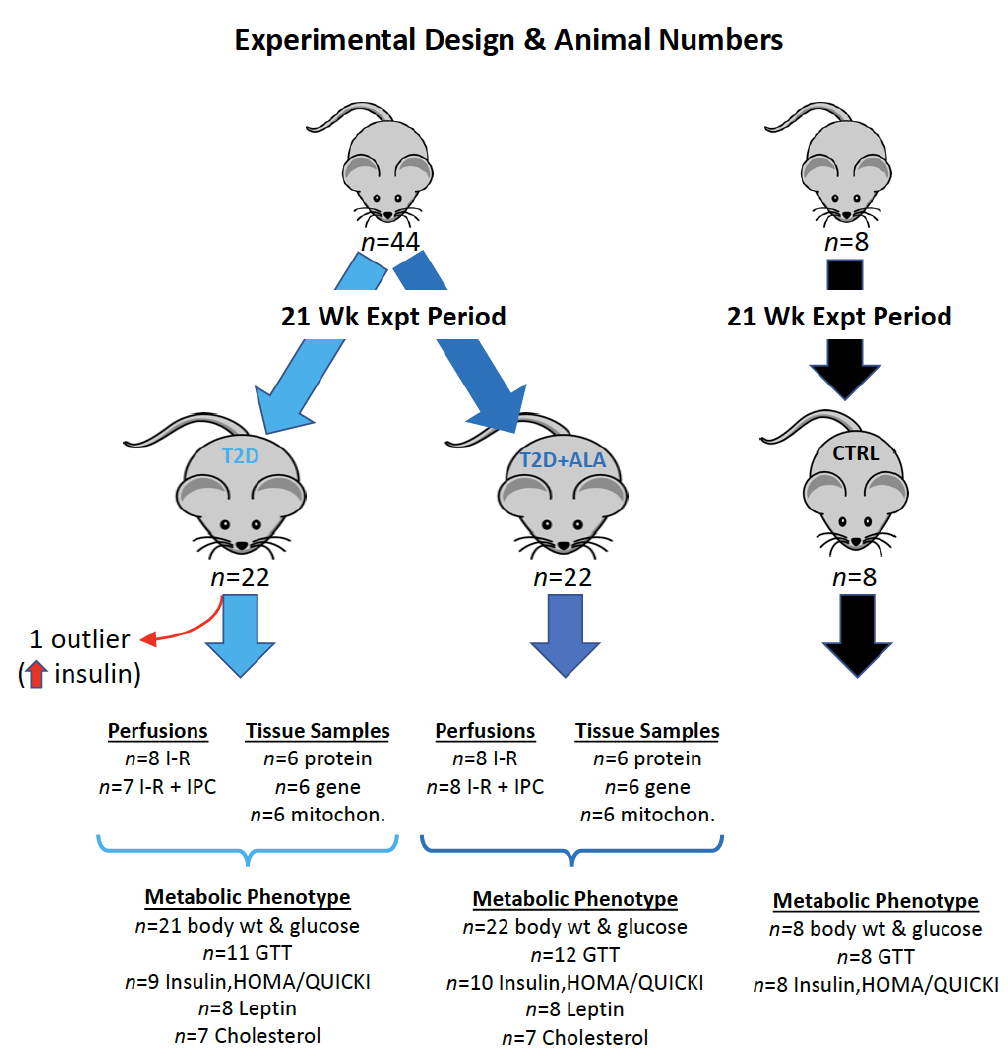
Figure A1. The details of “ n ” values and the varied analytical procedures within each group of mice are shown. Age-matched control comparator mice ( n = 8 / group) were assessed to confirm a T2D phenotype in experimental groups, with body weight, GTT analysis, and determination of fasting glucose and insulin, and the HOMA-IR and QUICKI measures, undertaken in all 8 mice. A total of 44 mice were subjected to the T2D protocol, half receiving ALA in the final weeks ( n = 22 / group). One T2D mouse was identified as an outlier via Grubbs test (unusually high insulin), and subsequently removed, giving n = 21 for T2D and n = 22 for T2D + ALA. While body weights and fasting glucose were measured in all mice ( n = 8 for control, n = 21 for T2D, n = 22 for T2D + ALA), metabolic assessment of the T2D and T2D + ALA groups was performed in randomly selected sub-sets of mice, as follows:.